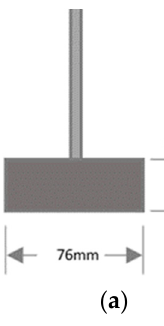
( a ) ( b ) Figure 10. The influence of geometry of mixers on flocculation: ( a ) torque readings by flat mixer and auger mixer during the flocculation of FFT-4 with polymer A3338; ( b ) dosage curves of three FFT samples flocculated by A3338 using flat mixer and auger mixer, respectively. Each dot is the average value of duplicate or more testing results in ( b ). 3.3. Effect of Dilution Dewatering performance of high density slurry is usually sensitive to solids concen- tration. As shown in Figure 11a, the diluted FFT samples had much lower NWR than the undiluted samples when the water added to dilute the FFT was considered for the calcu- lation of NWR (Equation (3)). As a result, the dewatering products of diluted FFT samples had lower solids contents in flocs (Figure 11b). Therefore, FFT dilution might not be a good practice for tailings treatment, assuming the degree of dewatering is the main per- formance indicator of interest. NWR for diluted FFT = (cid:2907)(cid:2911)(cid:2930)(cid:2915)(cid:2928) (cid:2928)(cid:2915)(cid:2922)(cid:2915)(cid:2911)(cid:2929)(cid:2915) (cid:2916)(cid:2928)(cid:2925)(cid:2923) (cid:2919)(cid:2924)(cid:2919)(cid:2930)(cid:2919)(cid:2911)(cid:2922) (cid:2890)(cid:2890)(cid:2904) (cid:2907)(cid:2911)(cid:2930)(cid:2915)(cid:2928) (cid:2919)(cid:2924) (cid:2919)(cid:2924)(cid:2919)(cid:2930)(cid:2919)(cid:2911)(cid:2922) (cid:2890)(cid:2890)(cid:2904) (cid:3404) 1 (cid:3398) (cid:4666)(cid:2869)(cid:2879)(cid:2929)(cid:2925)(cid:2922)(cid:2919)(cid:2914)(cid:2929) (cid:2933)(cid:2915)(cid:2919)(cid:2917)(cid:2918)(cid:2930)% (cid:2919)(cid:2924) (cid:2916)(cid:2922)(cid:2925)(cid:2913)(cid:2929)(cid:4667) (cid:2907)(cid:2911)(cid:2930)(cid:2915)(cid:2928) (cid:2933)(cid:2915)(cid:2919)(cid:2917)(cid:2918)(cid:2930)% (cid:2919)(cid:2924) (cid:2914)(cid:2919)(cid:2922)(cid:2931)(cid:2930)(cid:2915)(cid:2914) (cid:2890)(cid:2890)(cid:2904) (cid:2879) (cid:2911)(cid:2914)(cid:2914)(cid:2915)(cid:2914) (cid:2933)(cid:2911)(cid:2930)(cid:2915)(cid:2928) (cid:2933)(cid:2915)(cid:2919)(cid:2917)(cid:2918)(cid:2930)% (cid:2916)(cid:2925)(cid:2928) (cid:2914)(cid:2919)(cid:2922)(cid:2931)(cid:2930)(cid:2919)(cid:2925)(cid:2924)